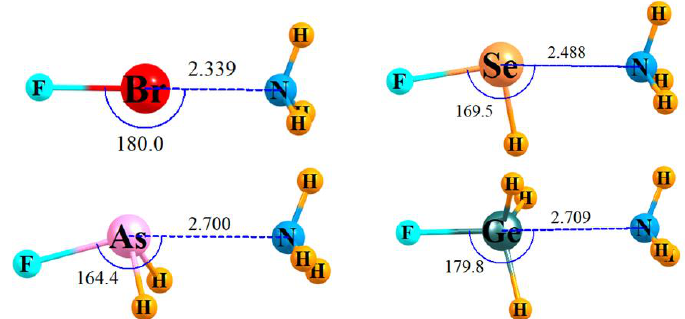
Figure 1. Geometries of sample noncovalently bonded complexes. Distance in Å and angles in degrees. The geometry that includes FSeH is not a pure minimum as it includes one negative frequency, which corresponds to torsional rotation of the NH 3 group.